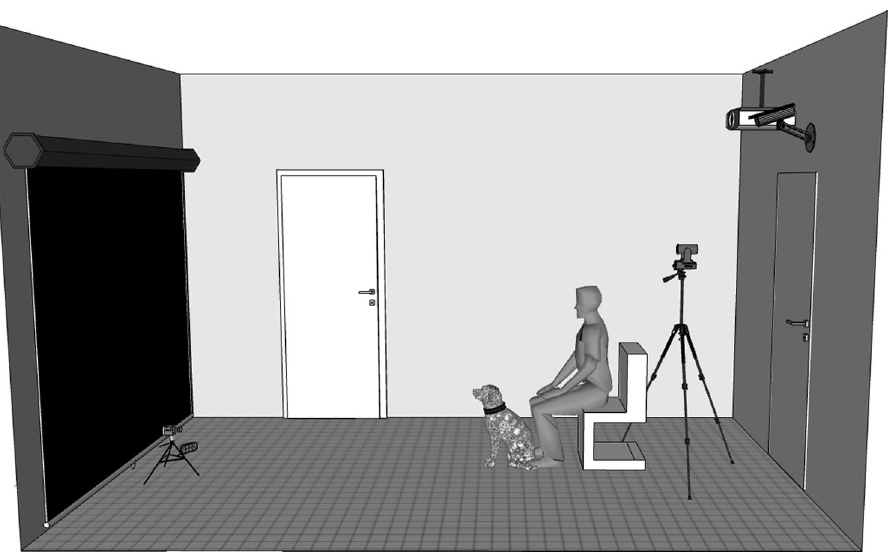
Figure 1. Experimental setup. Subjects sat 2.8 m away from the screen on which the chasing and independent motions were